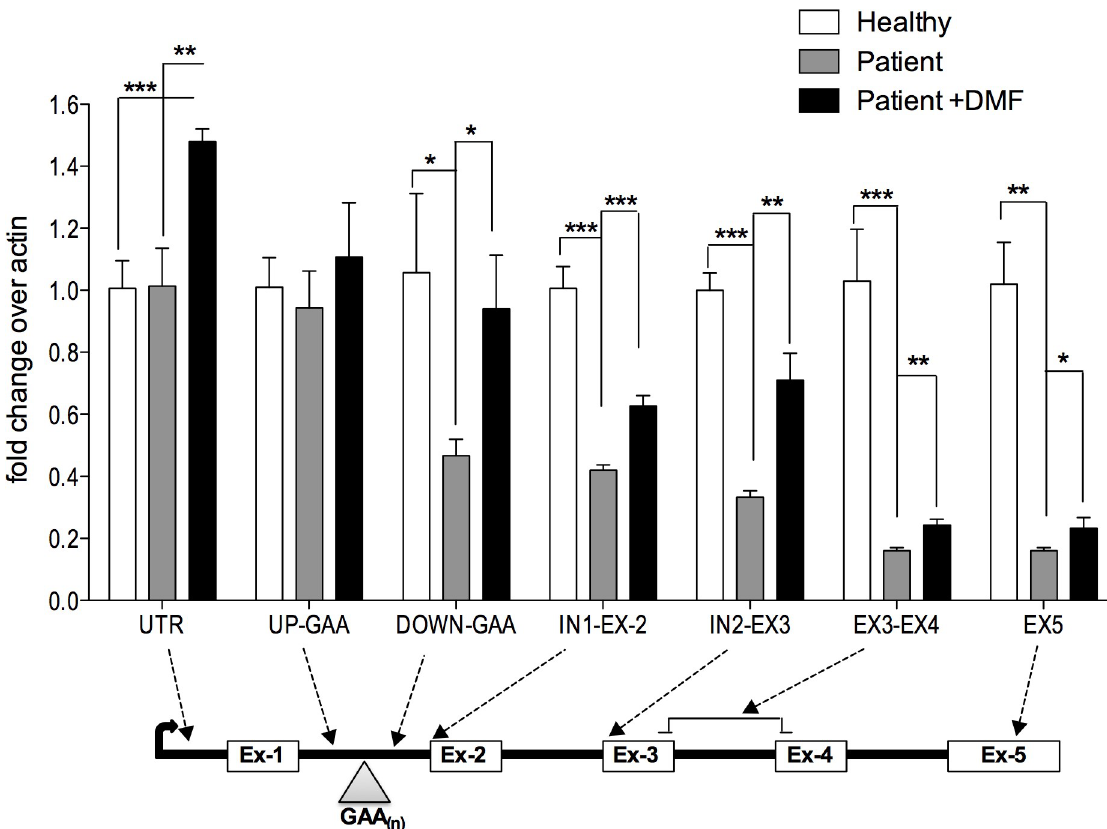
lymphoblast cells (GM14518) treated with 30uM DMF for 24 hr. Bars represent averages ± standard deviations (n = 3, each group). Bars represent averages ± standard deviations (p < 0.05 � , p < 0.01 �� , p < 0.001 ���